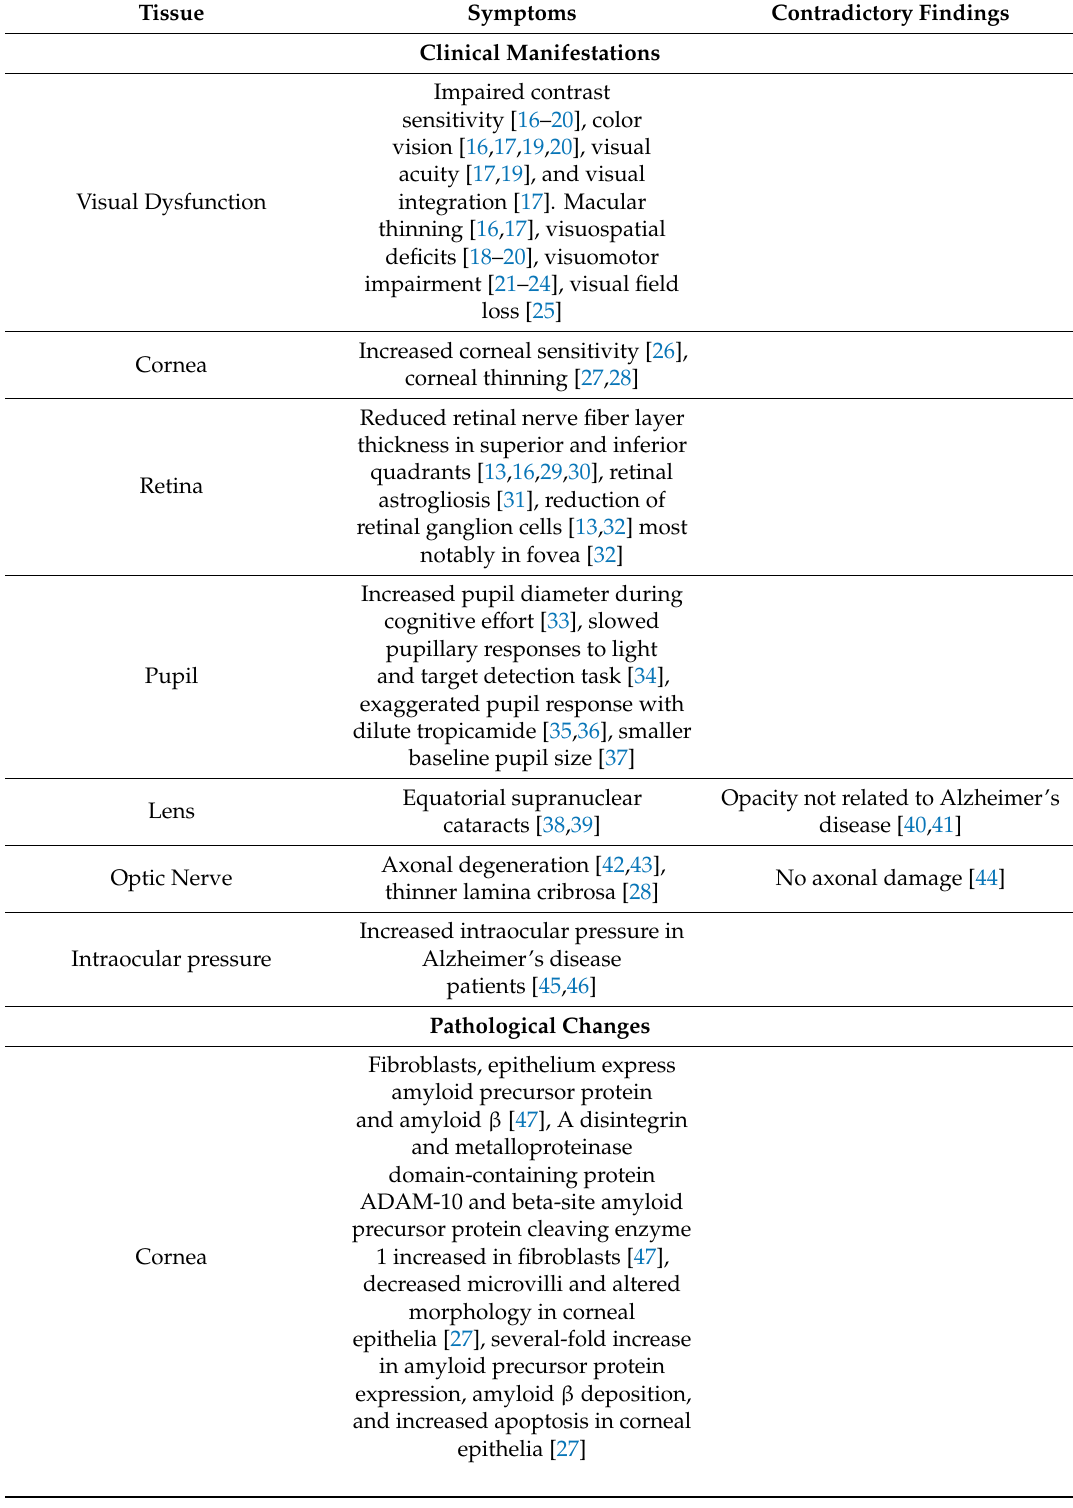
Table 1. Ocular symptoms associated with Alzheimer’s disease